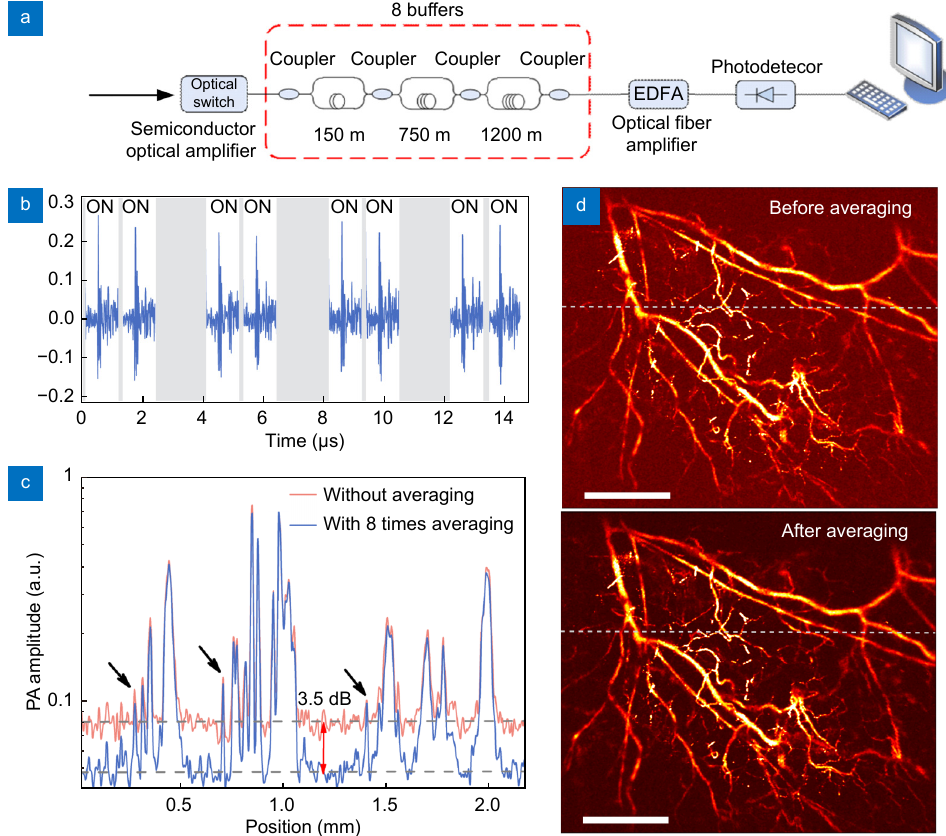
Fig. 6 | ( a ) The optical signal duplication system. The ultrasonically modulated laser light is duplicated into 8 copies. ( b ) Demodulated ultrasound signals of the 8 copies. ( c ) B-scan signals before and after signal averaging, showing a 3.5 dB reduction in the background noise. ( d ) In vivo PAM results before and after signal averaging. The visibility has been effectively enhanced by the signal averaging method. Figure reproduced with permission from ref. 35 , Optical Society of